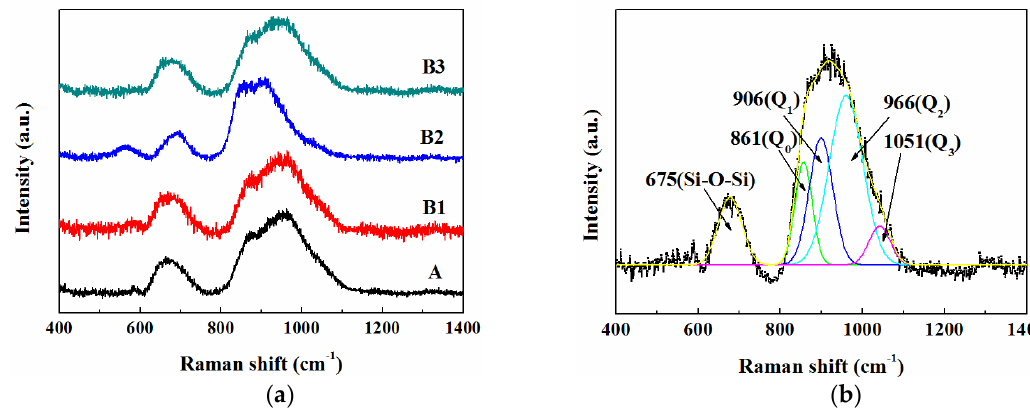
Figure 7. Raman spectra: ( a ) A, B1, B2, and B3 sample Raman spectra ranging from 400 to 1400cm −1 ; ( b ) typical deconvolution of the Raman spectra.